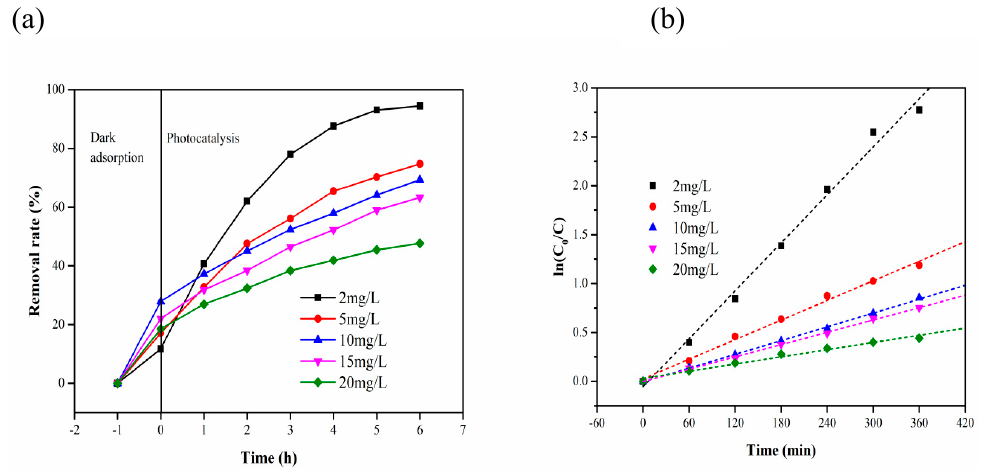
Figure 8. ( a ) Photocatalytic degradation under different initial concentrations of MB; ( b ) kinetics of photocatalysis of MB with different initial concentrations on composite carrier.